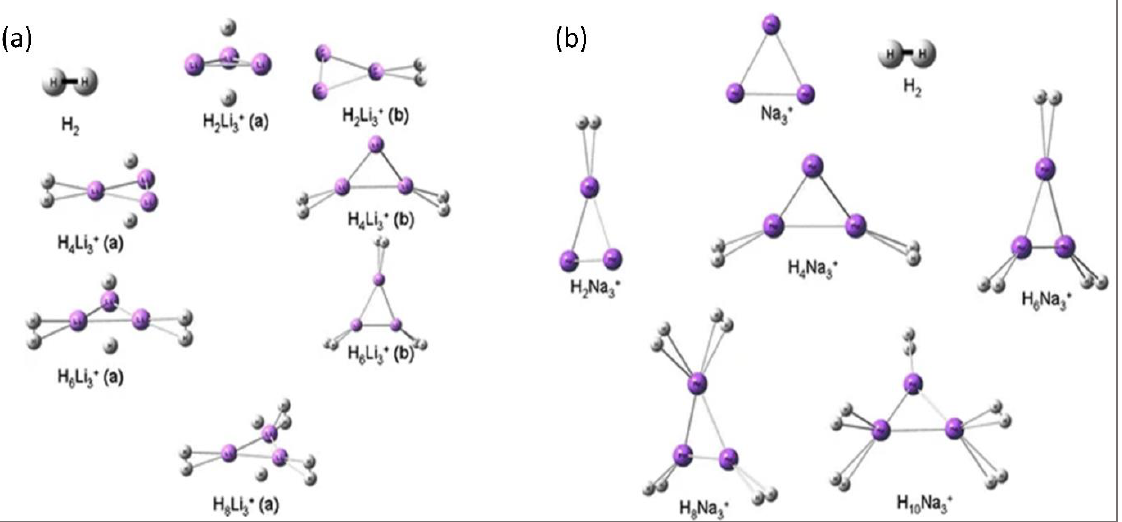
Figure 3. ( a ) Forms of H 2 -bound Li 3+ and ( b ) H 2 -bound Na 3+ . This figure is reproduced from Refer- ence [17].